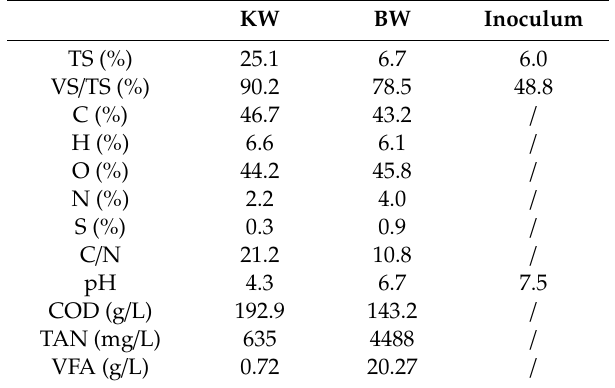
Table 1. Main characteristics of kitchen waste, blackwater, and inoculum.